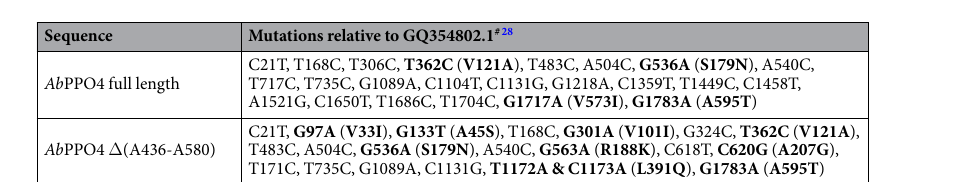
Table 1. Sequences of the cloned genes. # The sequences are given as mutations relative to GQ354802 (mRNA for the reference sequence for Ab PPO4, Uniprot: C7FF05) with non-silent mutations shown in bold and followed by the respective altered amino acid in parentheses. Sequence numbers start with 1 at the A of the start codon and M of the peptide chain for nucleobases and amino acids,